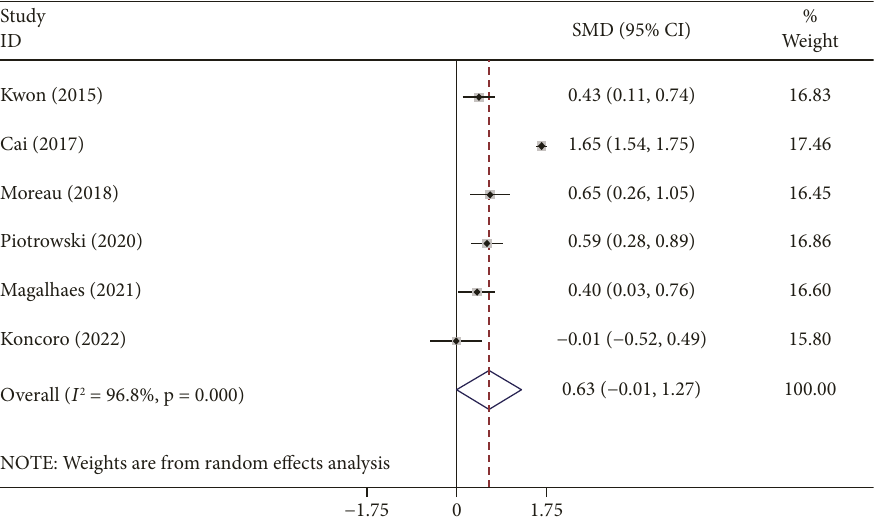
Figure 2: Meta-analysis of differences in the NLR level between hospitalized cirrhotic patients who developed infection compared to those who did